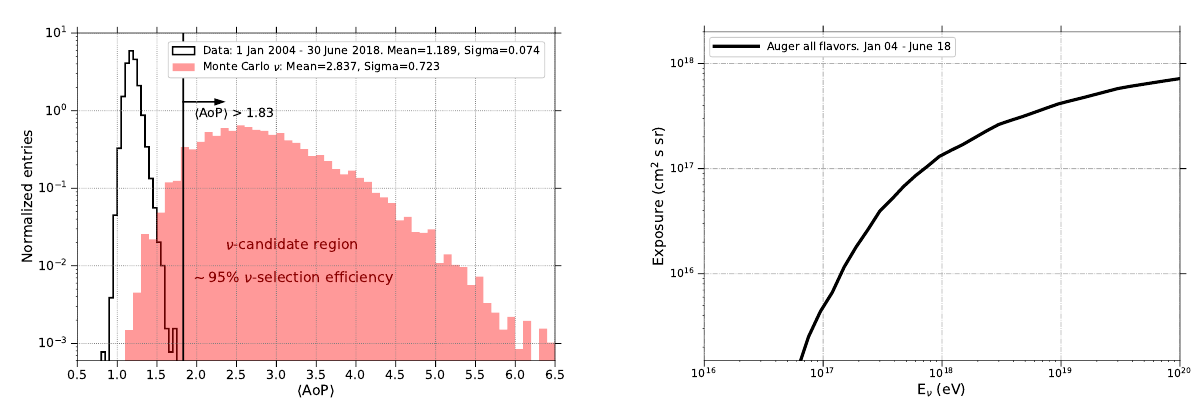
Figure 1. Distribution of (cid:104) AoP (cid:105) for the real events (black his- togram) and Monte Carlo-simulated ν τ events (red-shaded his- togram) triggering the SD of Auger and that also fulfill the in- clined Earth-Skimming (ES) selection criteria. Real data up to 30 June 2018. The vertical dashed line indicates the position of the optimized cut (cid:104) AoP (cid:105) = 1.83 above which an event would be re- garded as a neutrino candidate. As indicated in the plot, ∼ 95% of the simulated neutrinos pass the inclined and neutrino identi- fication criteria.